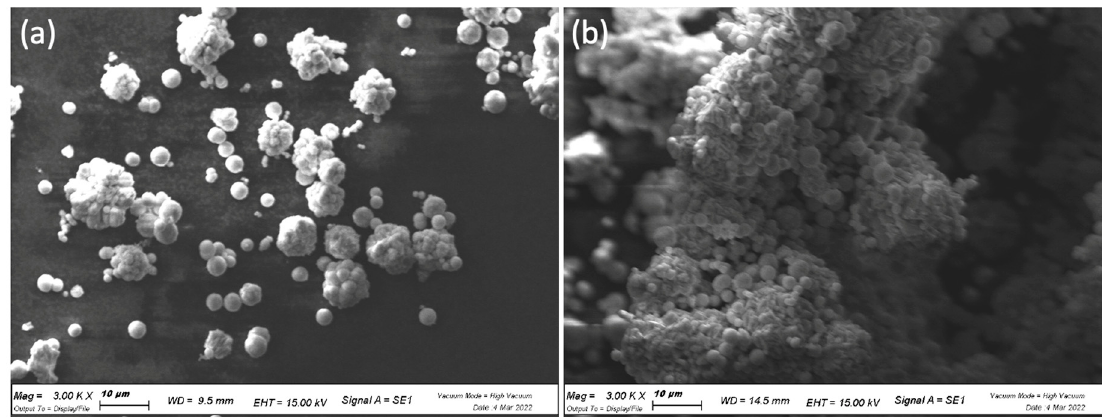
Figure 2. ( a ) SEM of CdS-HT; ( b ) SEM of CdS-HTa400. The EDS patterns of CdS-HT, CdS-HTa400 and of commercial CdS reported in Figure 3 are very similar, and clear peaks of cadmium and sulfur are evident: CdS-HT was composed of 51.8% Cd element and 48.2% S element, and CdS-HTa400 was composed of 51.6% Cd and 48.4% S, while commercial CdS was composed of 51.7% Cd and 48.3% S. The atomic ratio is close to one, indicating that all samples are around the nominal